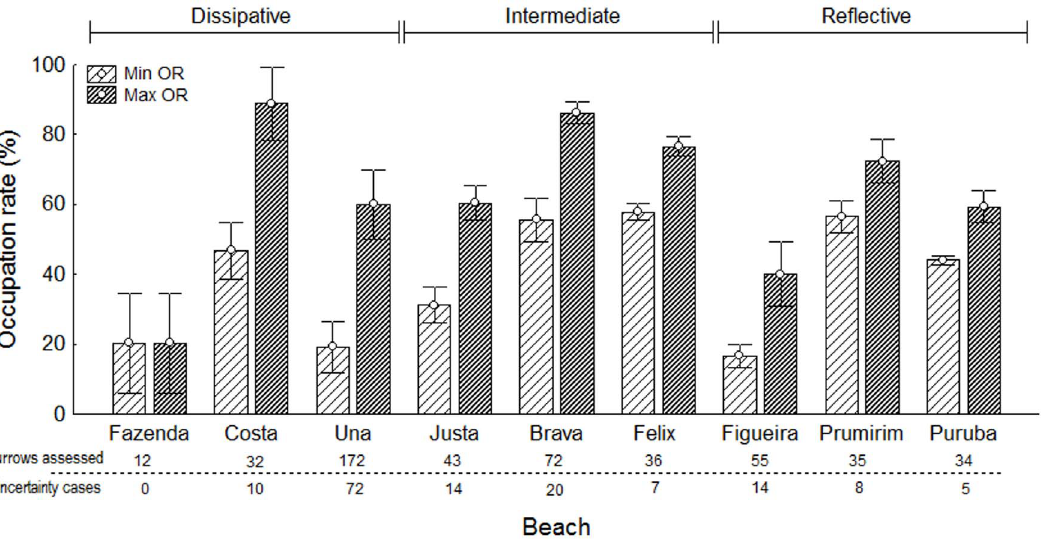
Figure 3. Minimum and maximum occupation rate by beach. Mean and standard error of occupation rate of Ocypode quadrata burrows (minimum and maximum rates), by beach. The total number of burrows assessed and the number of uncertainty cases, on each beach, are shown below the x axis.